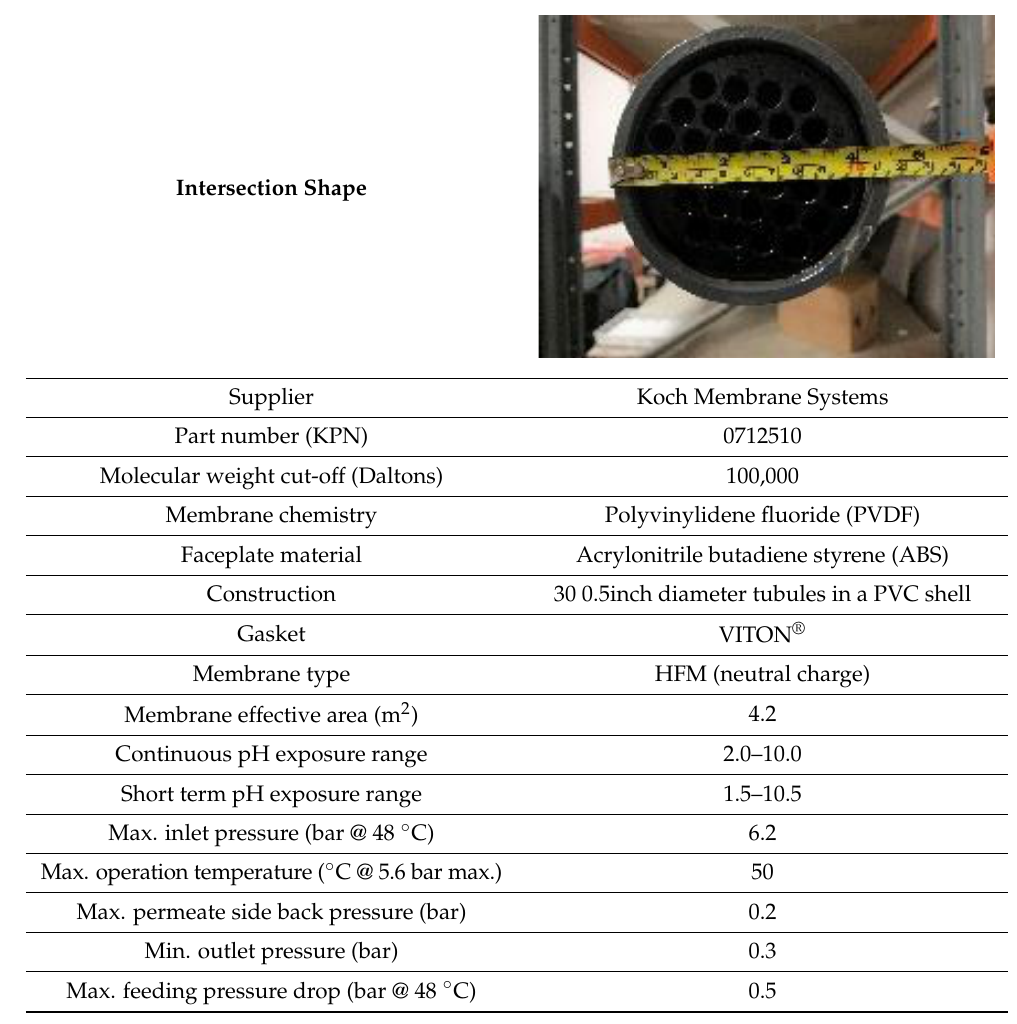
Intersection Shape